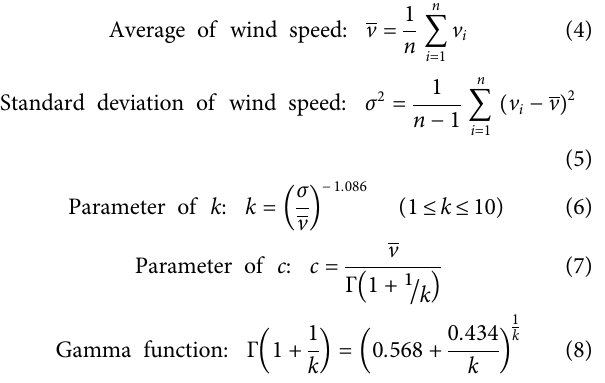
Frontiers in Energy Research |